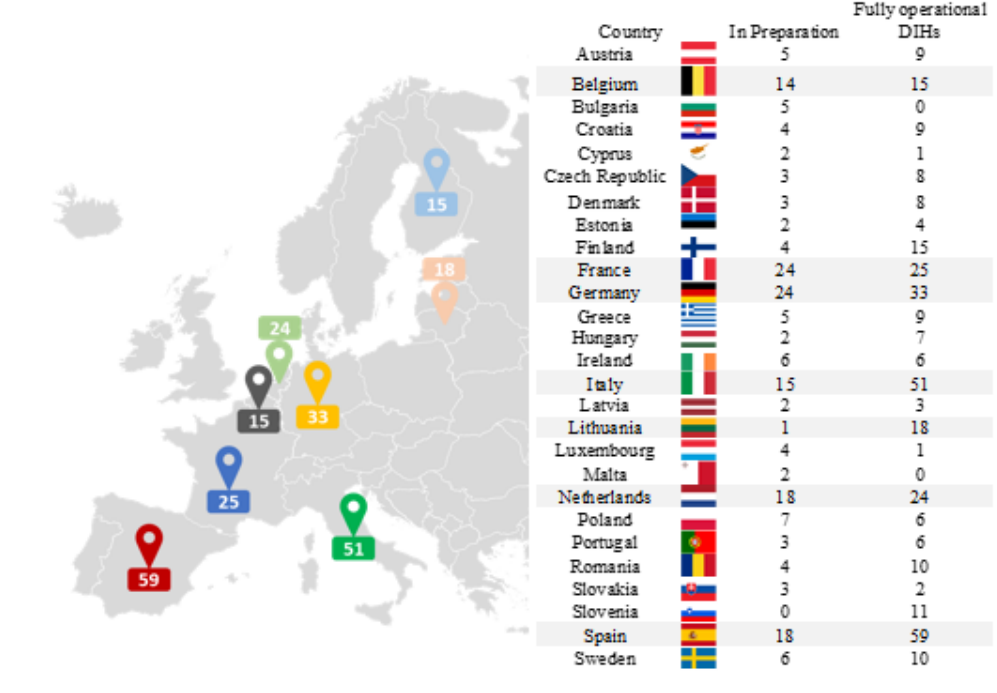
Figure 2. Top 7 EU countries by number of fully operational DIHs.